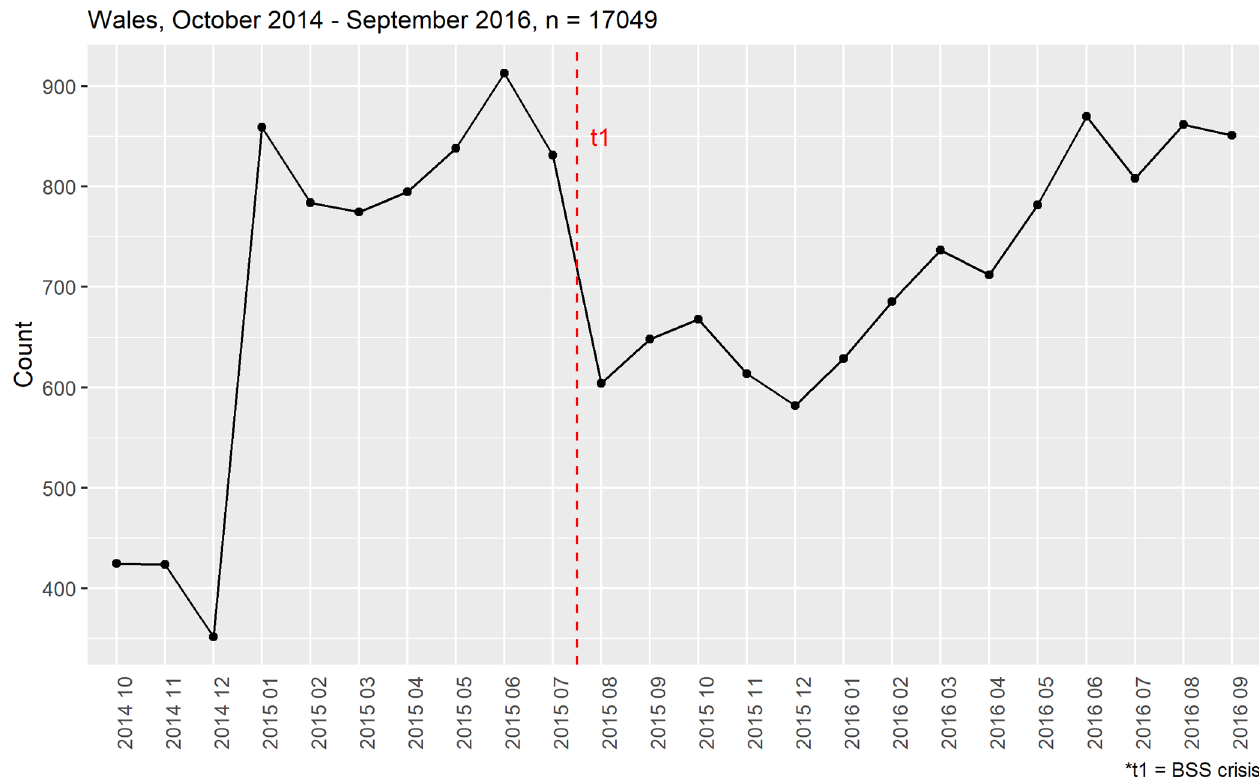
Figure 5: Number of crimes recorded in Study 1, per